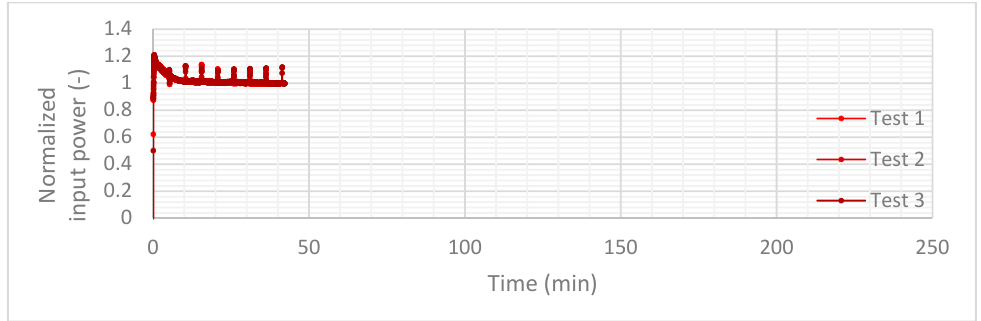
Figure A9. Normalized input power to the air compressor unit at the thermostatic temperature of 0 °C.